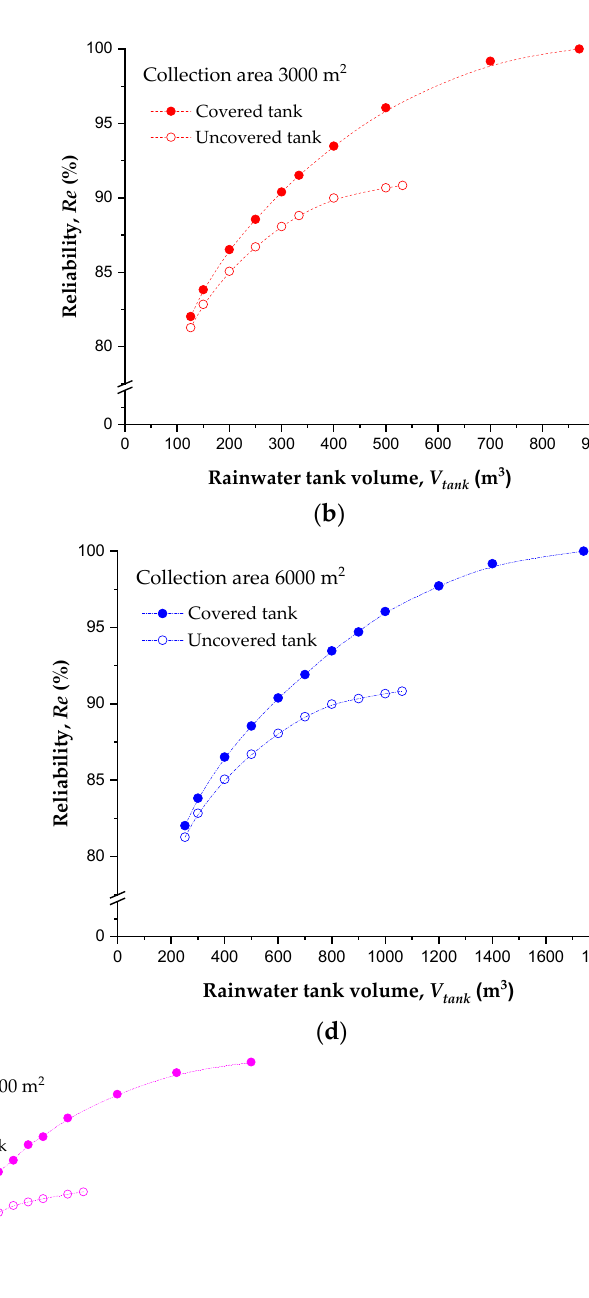
( f ) Figure 7. Reliability curves of covered rainwater harvesting system in relation to tank sizes to meet the demand of a tomato crop cultivated in greenhouses with rainwater collection areas: ( a ) 1000 m 2 ; ( b ) 3000 m 2 ; ( c ) 5000 m 2 ; ( d ) 6000 m 2 ; and ( e ) 10,000 m 2 . A comparative presentation was also presented ( f ). Finally, in Figure 8a comparative presentation between covered and uncovered